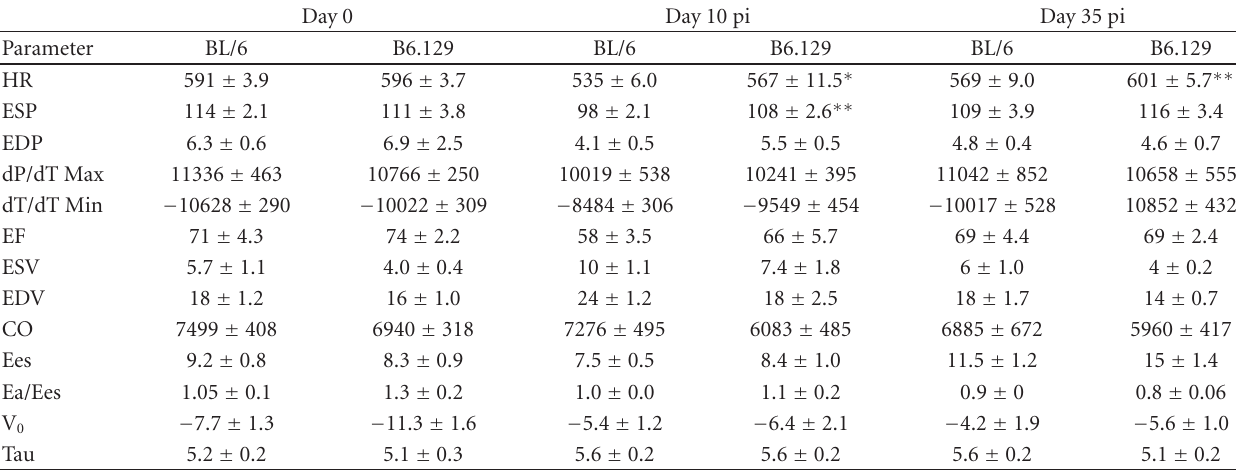
Table 1: Similarity in cardiac function of C57BL/6 versus B6.129 mice prior to infection (day 0) and during acute (day 10) or chronic (day 35) CVB3 myocarditis based on pressure-volume analysis.